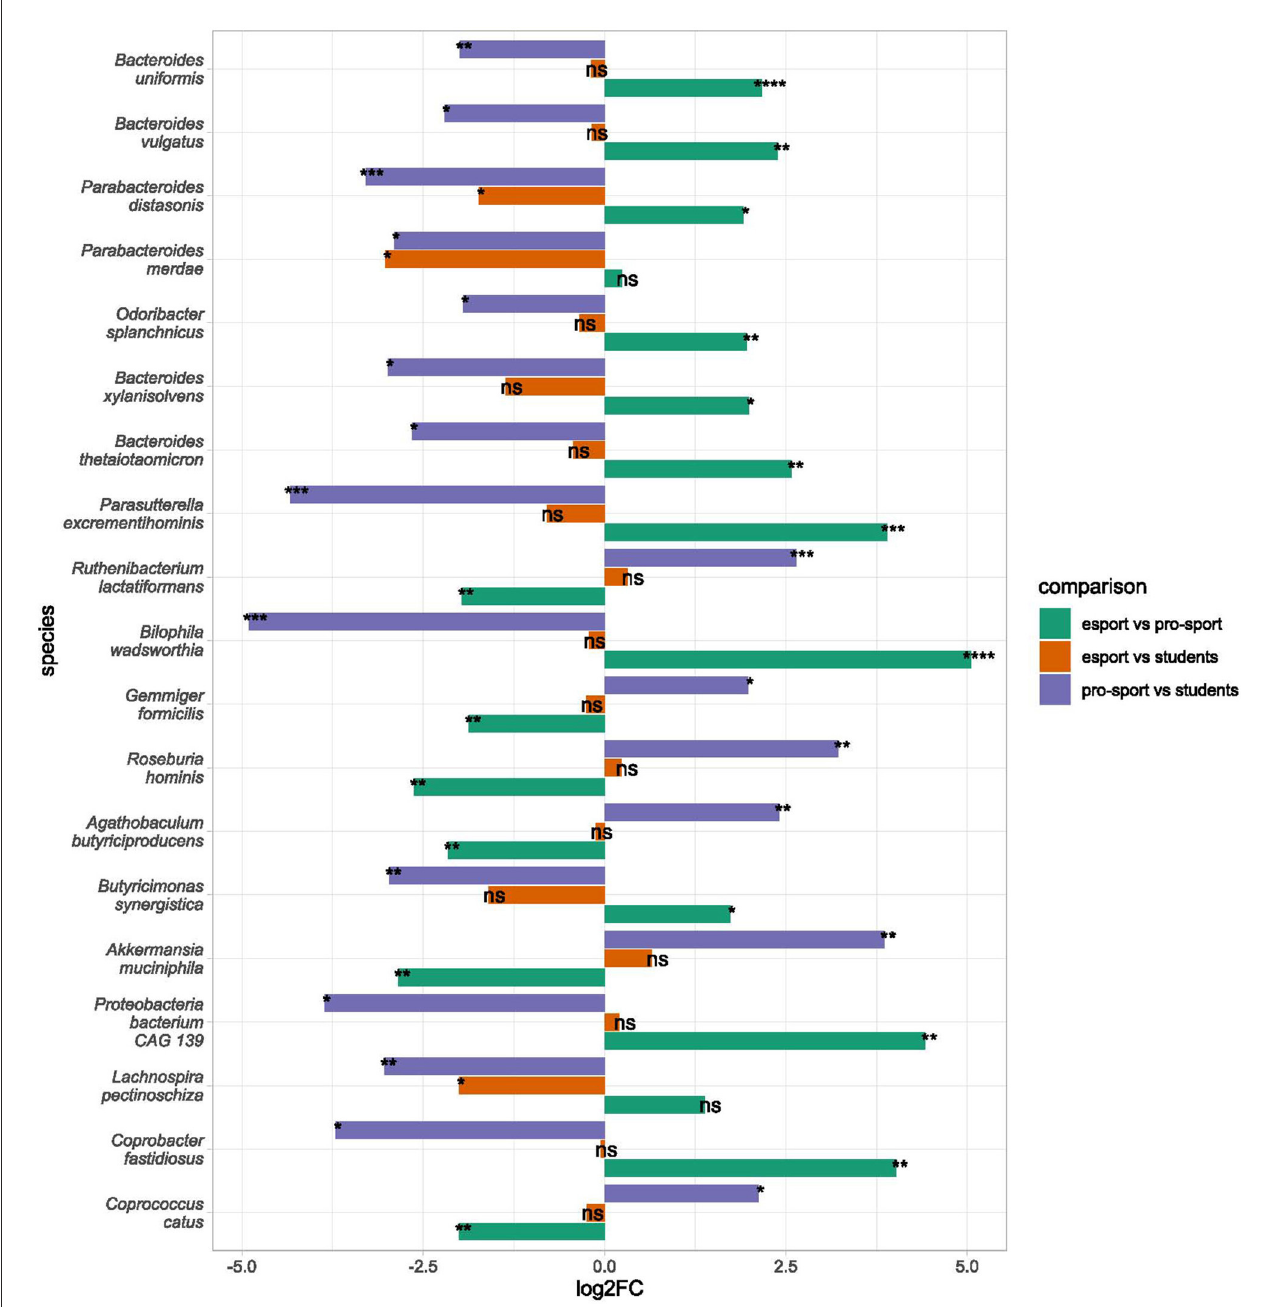
FIGURE4 Differential taxa in bacterial species in esports players, professional athletes, and students. Bars indicate log2 from fold change (by the LINDA model. Significant changes are marked with asterisks as follows: ). Only species differential in at least two comparisons are presented. Species are sorted according to their mean abundance. ns: p > 0.05, *: p ≤ 0.05, **: p ≤ 0.01, ***: p ≤ 0.001, ****: p ≤